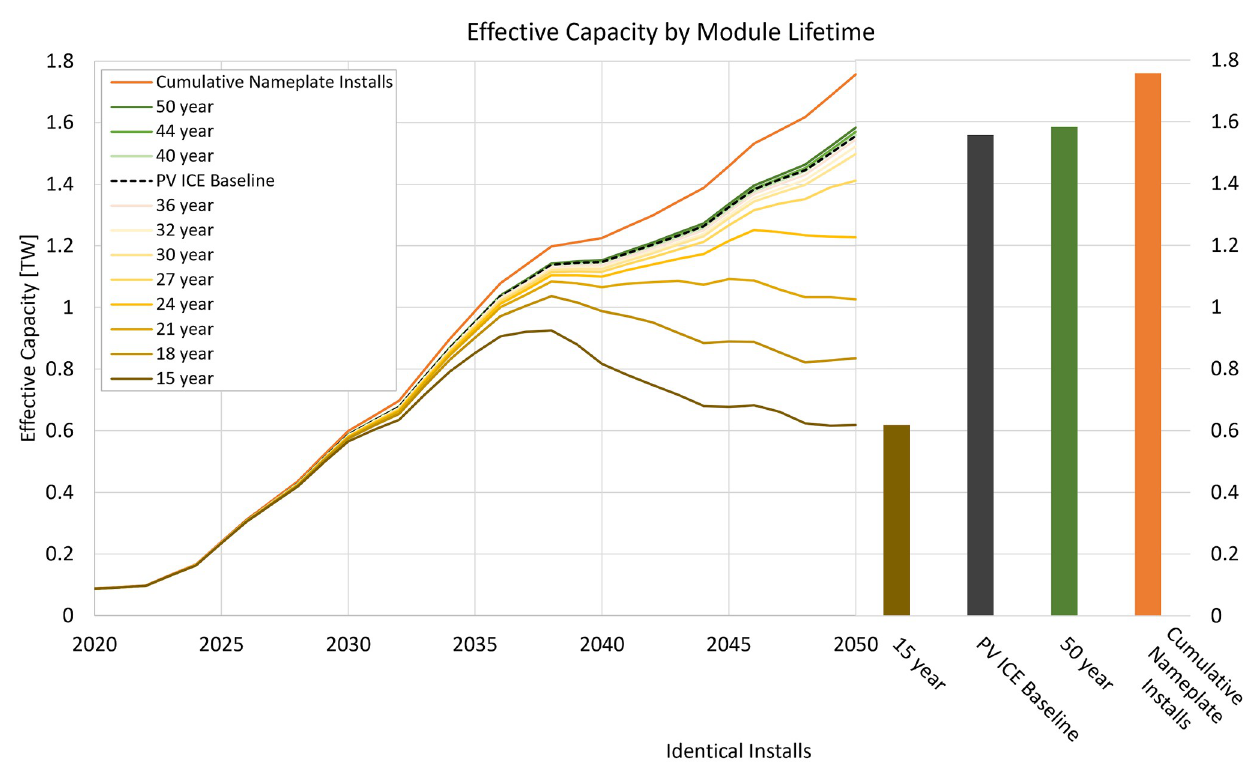
Fig 2. Effect of module lifetime and degradation on effective capacity. Effect of module lifetime on effective capacity, annually from 2020 through 2050, assuming identical deployment rates. The bar chart at the right shows the 2050 effective capacity of a 15-year module, the PV ICE baseline (a ~35-year module), and a 50-year module. The 1.75-TW cumulative nameplate installed capacity is provided as a comparison.